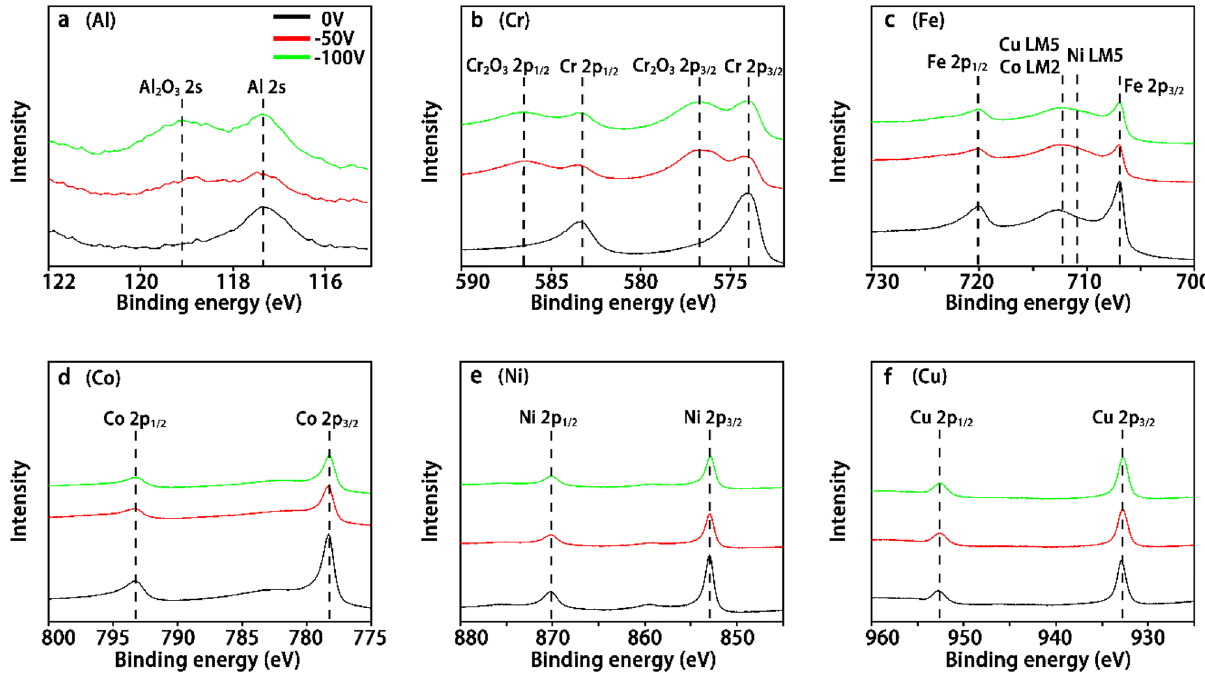
Figure 7. XPS high-resolution spectra of ( a ) Al-2 s; ( b ) Cr-2p; ( c ) Fe-2p; ( d ) Co-2p ( e ) Ni-2p; and ( f ) Cu-2p.